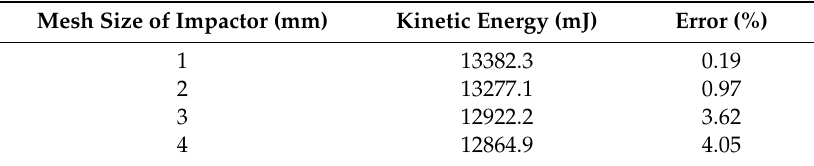
Table 1. Relationship between the mesh size of impactor and the kinetic energy